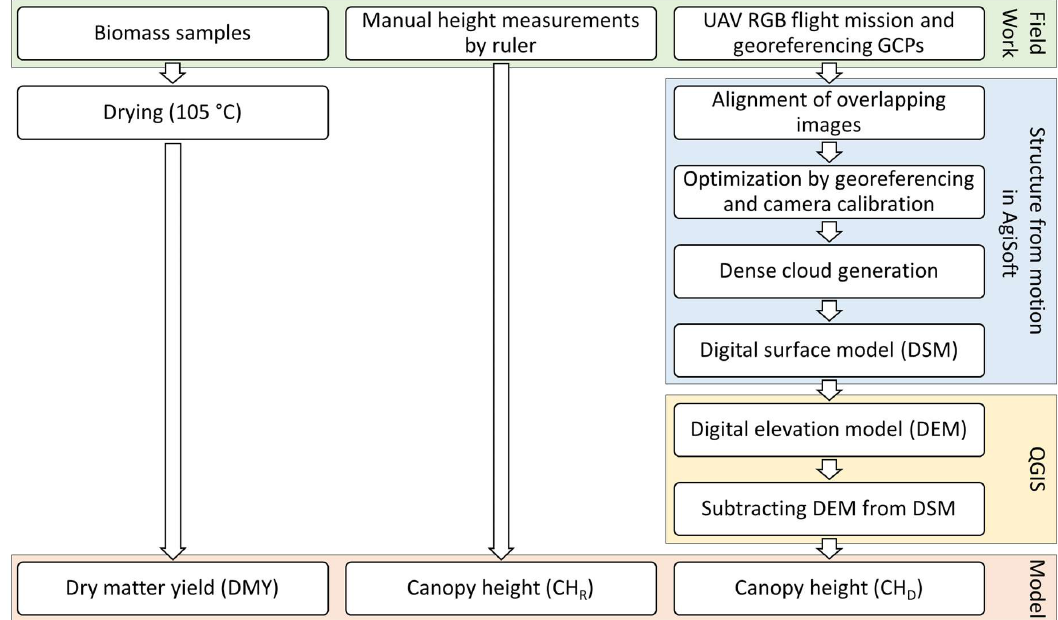
Figure 2. Workflow of biomass sampling, manual and UAV-based structure from motion (SfM) height measurement.